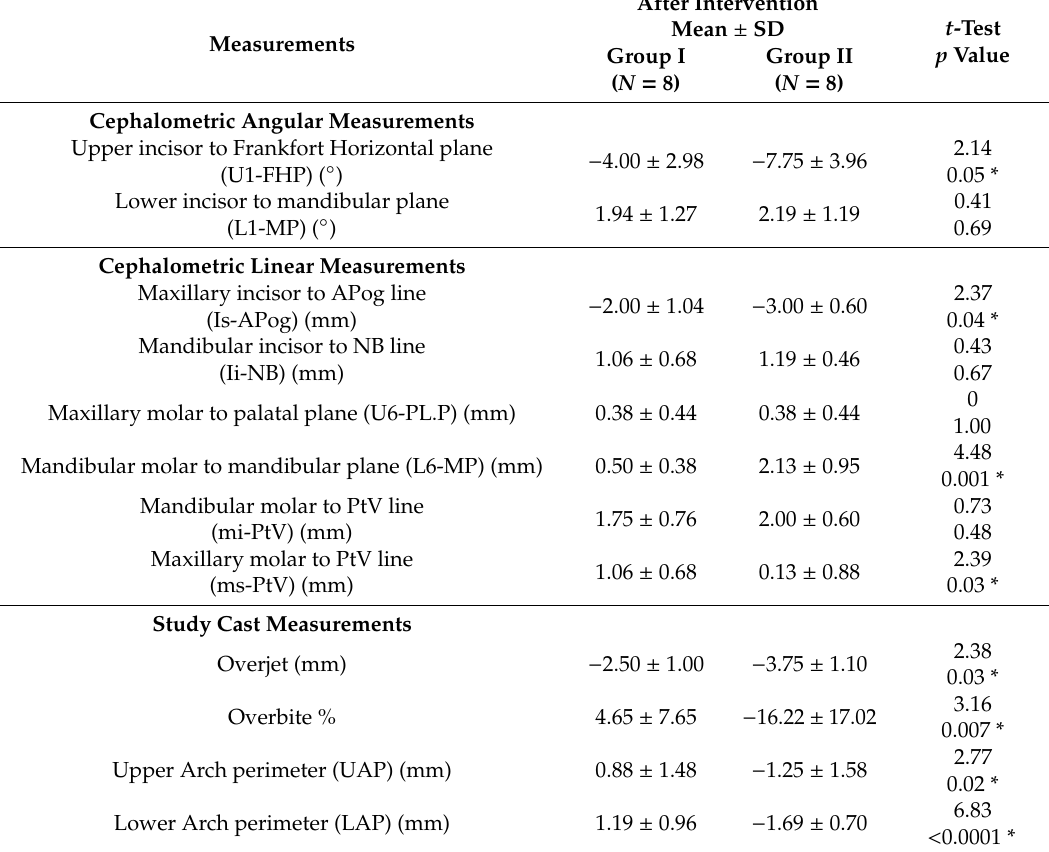
Table 4. Mean dentoalveolar angular and linear measurements change after intervention between Group I and Group II. Measurements